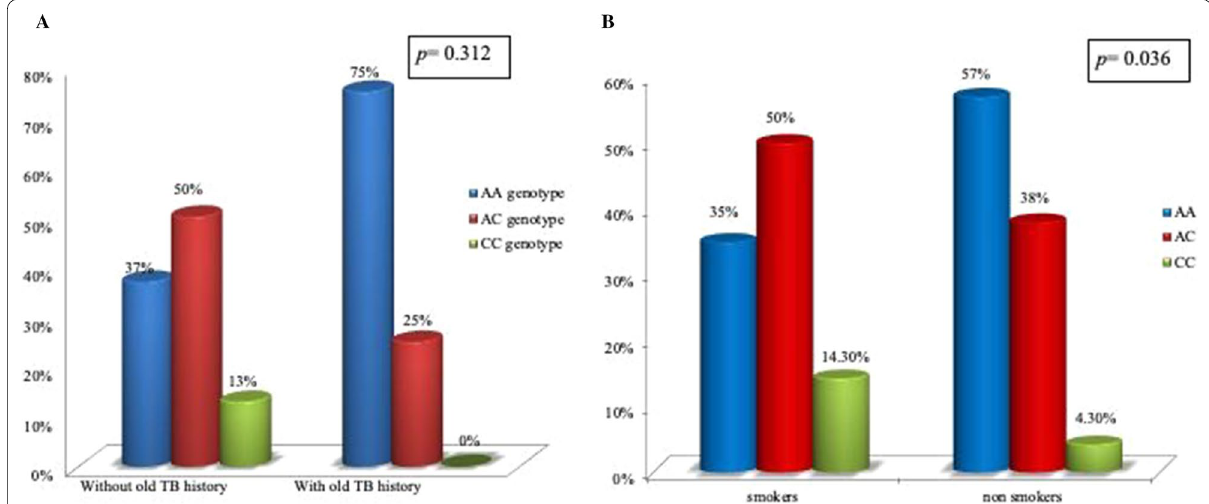
Fig. 2 A P2X7 receptor 1513A/C genotypes frequency distribution among studied population regarding previous history of old TB; B P2X7 receptor 1513A/C genotypes distribution among smoker (either active or former smokers) and non‑smoker subjects included in the